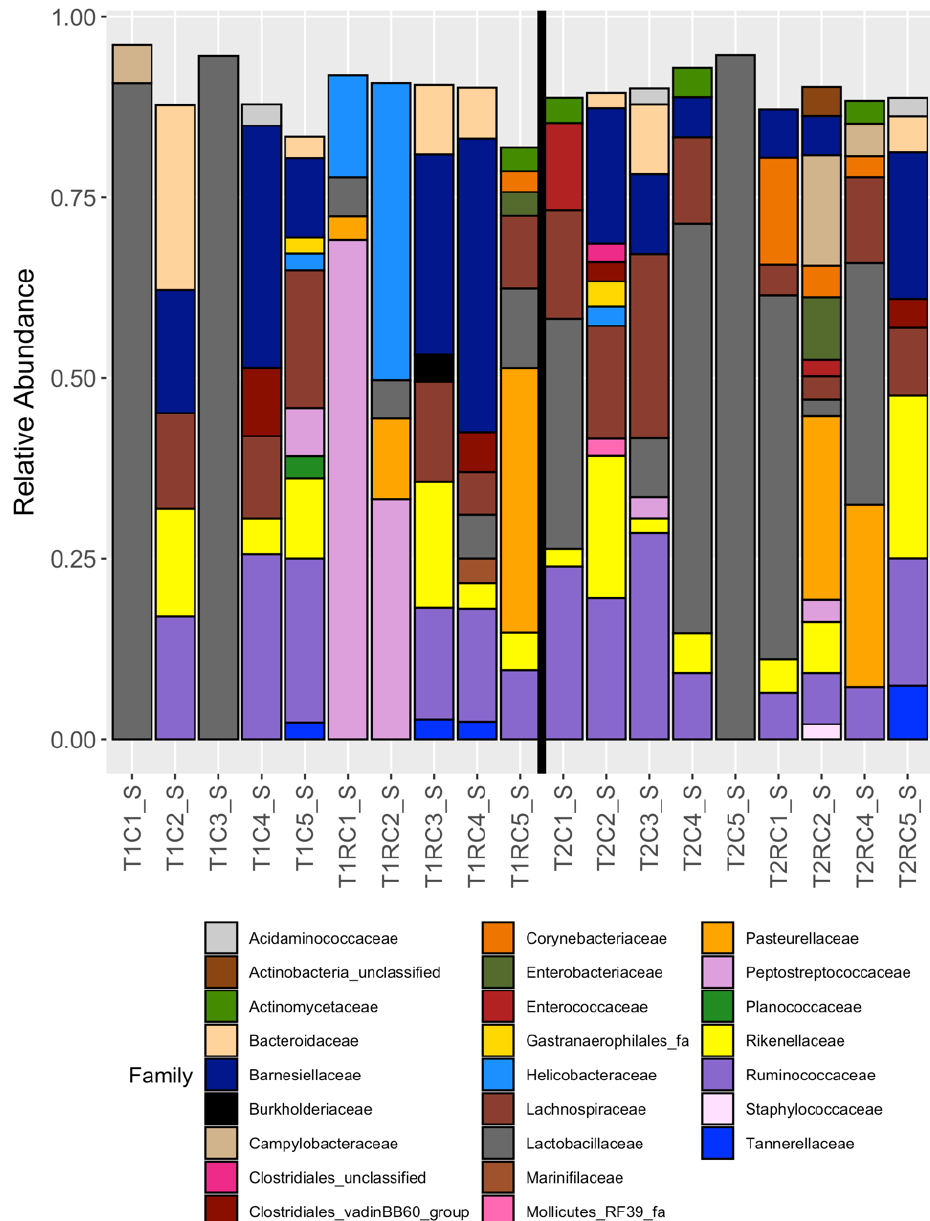
Figure 1. The relative abundance of families observed for each cloacal swab samples that had >= 3005 reads; n = 19. The vertical black line divides the samples belonging to the two dietary treatments.